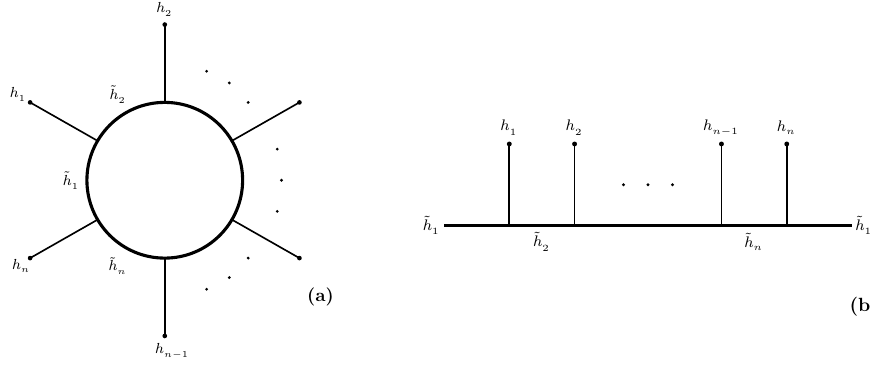
Figure 1 . The n -point torus block in the necklace channel (a) . It can be thought of as the ( n + 2)- point block in the comb channel of the plane CFT 2 with identified endpoints (b) . Note that ˜ h 1 on the necklace diagram is always between h 1 and h n .